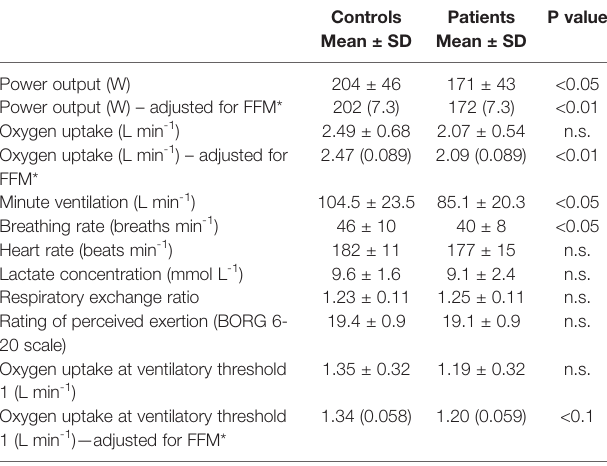
TABLE 2 | Peak values and oxygen uptake at ventilatory threshold 1 attained during ramp exercise test.